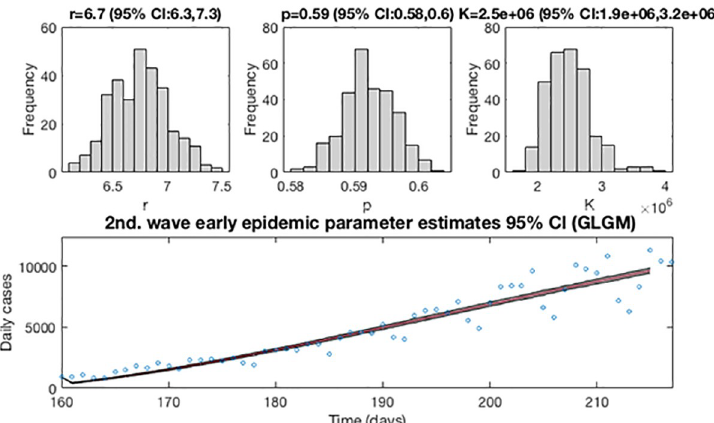
Fig 13. Resulting curves after re-fitting of parameters of the early epidemic phase. Blue circles are the cases reported daily; red line corresponds to the best fit of the GLGM to the data. Grey lines correspond to the m bootstrapping realizations of the epidemic curves. Black lines correspond to the 95% CI bounds. The empirical distributions for parameter estimations are displayed in the top panel.